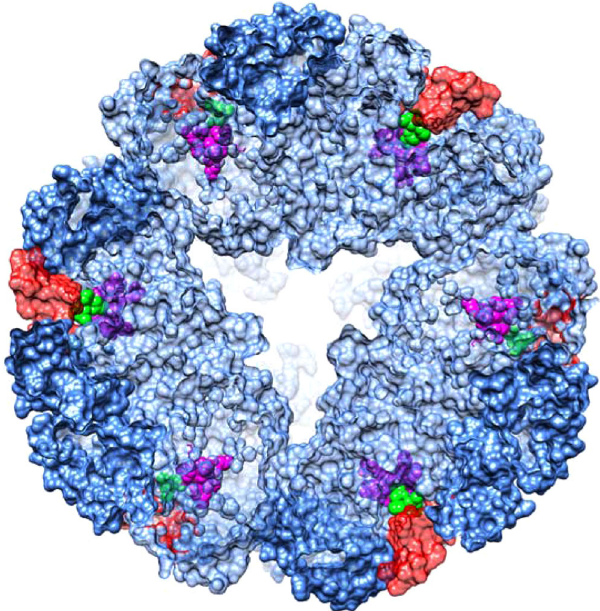
Fig. 7 Active sites and bound SHA molecules in a 40 Å slice of the H. pylori urease dodecamer. Six sets of active site residues (magenta), the fl ap region (red) and SHA inhibitor molecules (green) of the total of twelve sets are visible in this slice of the dodecamer. The active sites are not readily accessible from the outer surface of the